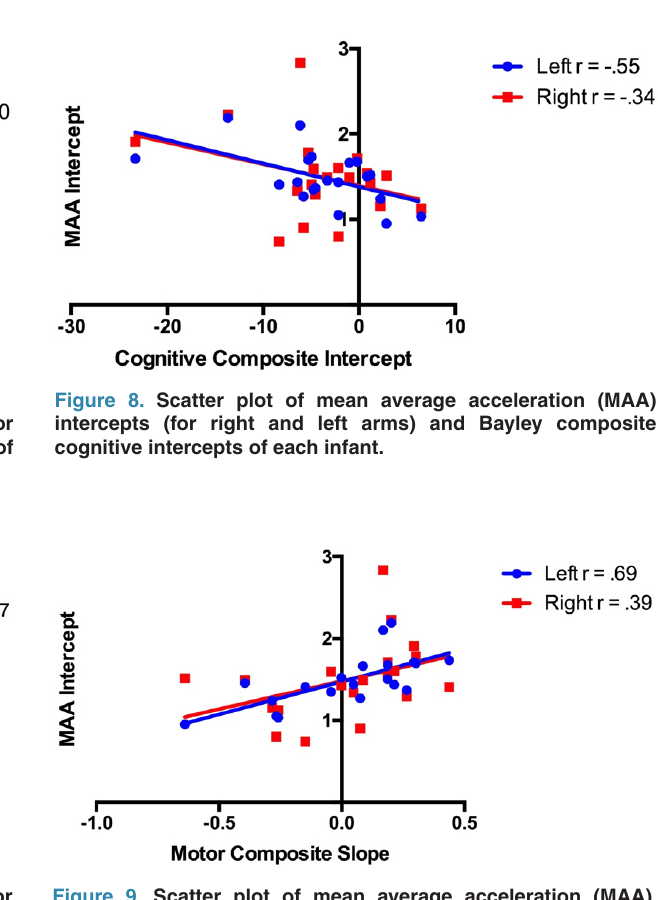
Figure 9. Scatter plot of mean average acceleration (MAA) intercepts (for right and left arms) and Bayley composite motor slopes of each